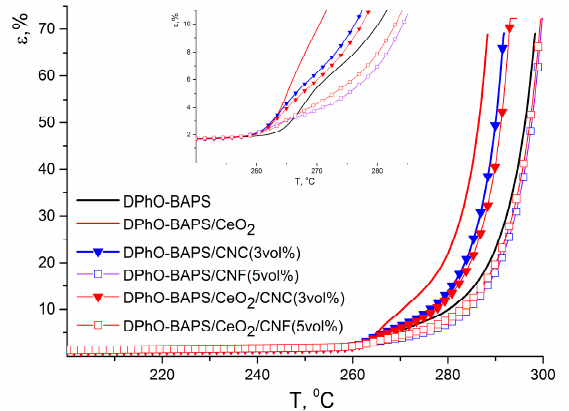
Figure 7. TMA curves of DPhO-BAPS and the corresponding nanocomposites (inset shows the thermal behavior of the samples at small deformations).